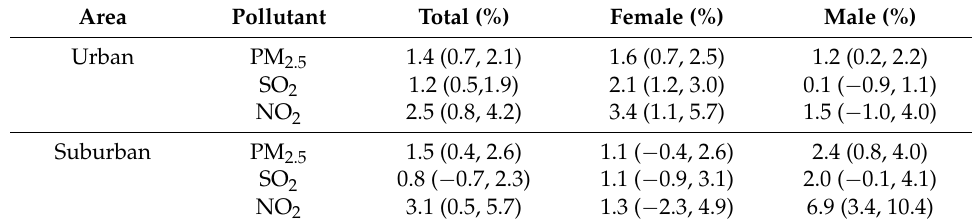
Figure 2. Relative risks (RRs with 95% CI) of hospital emergency room visits for respiratory complaints in association with per 10 µ g/m 3 increase in PM 2.5 , SO 2 and NO 2 for the urban population of Jinan at different lags (lag0, lag1, lag2, lag3, lag4). Table 3. Percent increase (95% CI) of hospital emergency room visits for respiratory diseases with a 10 µ g/m 3 increase in PM 2.5 , SO 2 and NO 2 in one-pollutant models for the urban and suburban populations in Jinan.